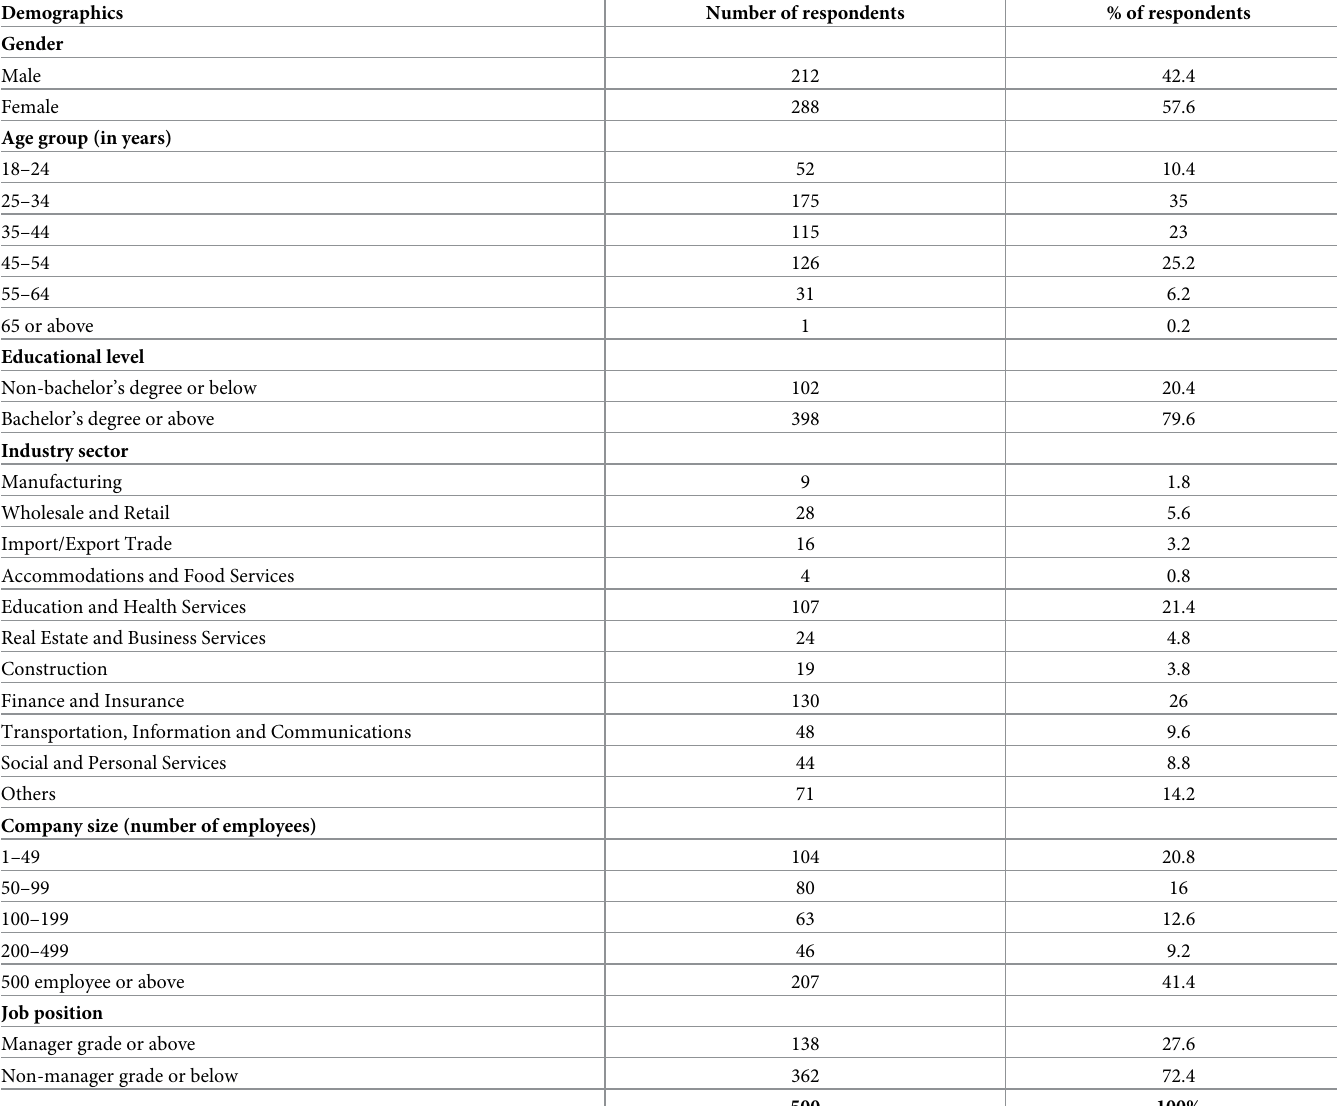
Table 1. Demographic characteristic of